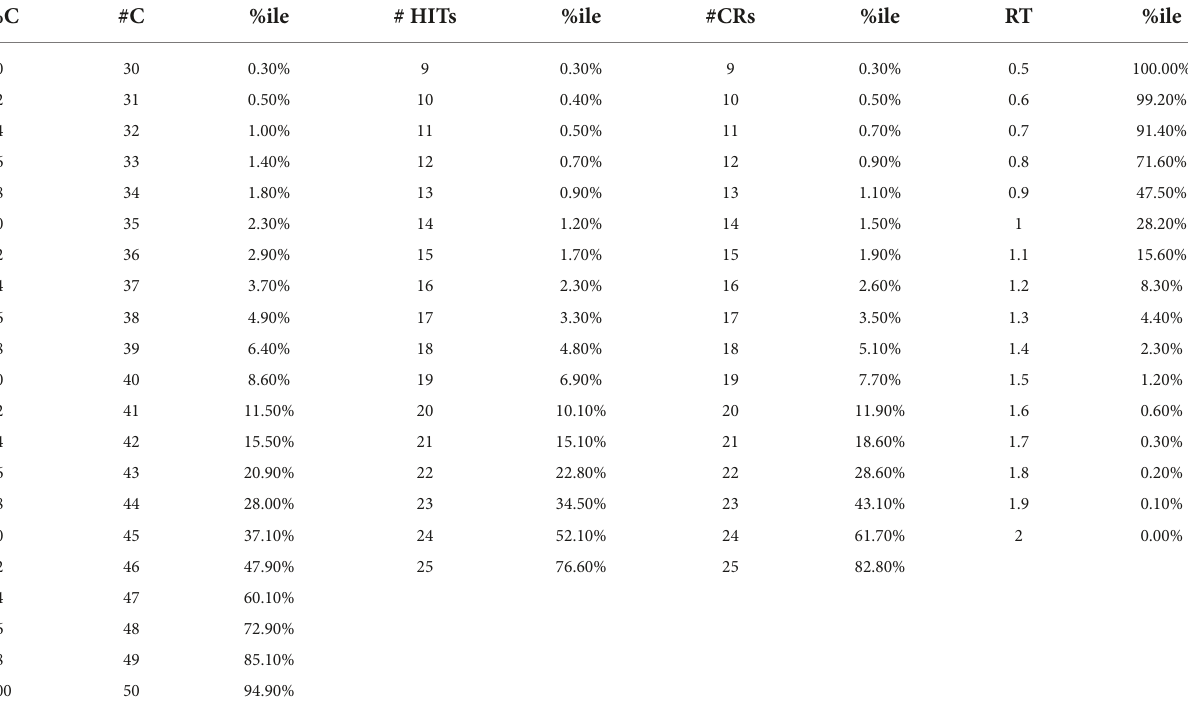
TABLE 1 Tabulated data for 282,140 on-line MemTrax users, with percentiles